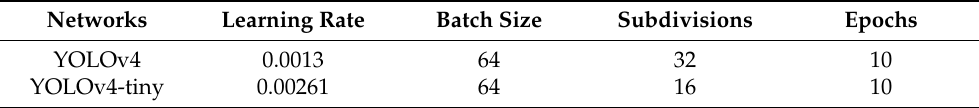
Table 6. Hyperparameters to train object detection networks using the brake pad dataset.